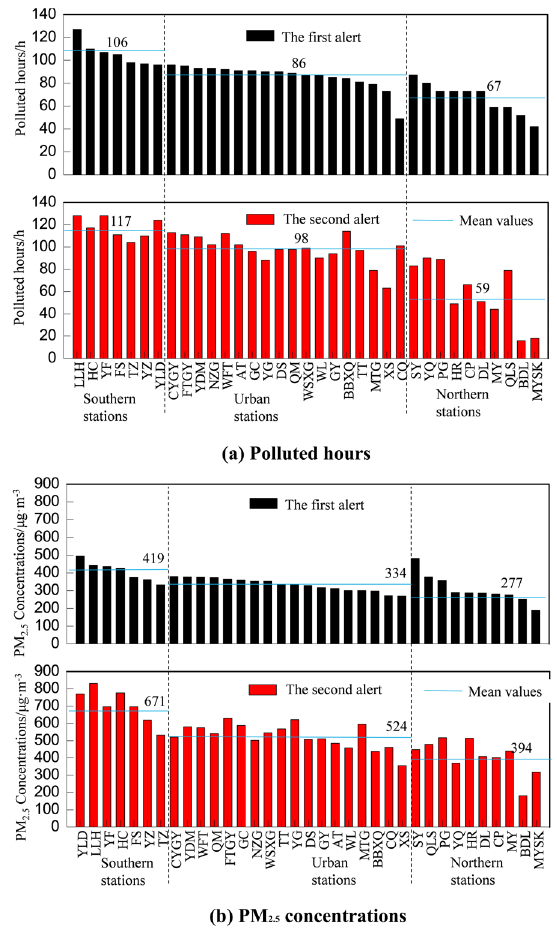
Figure 2. ( a ) The number of heavily polluted hours and ( b ) extreme values of hourly averaged PM 2.5 concentrations at different stations in Beijing during two red alerts.